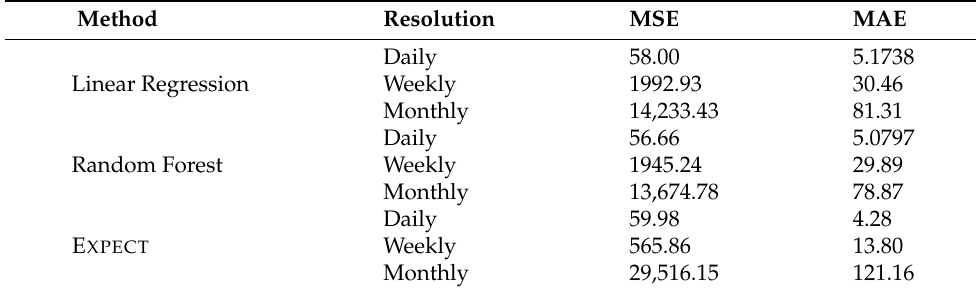
Table 5. Performance evaluation with RDC and CDC.